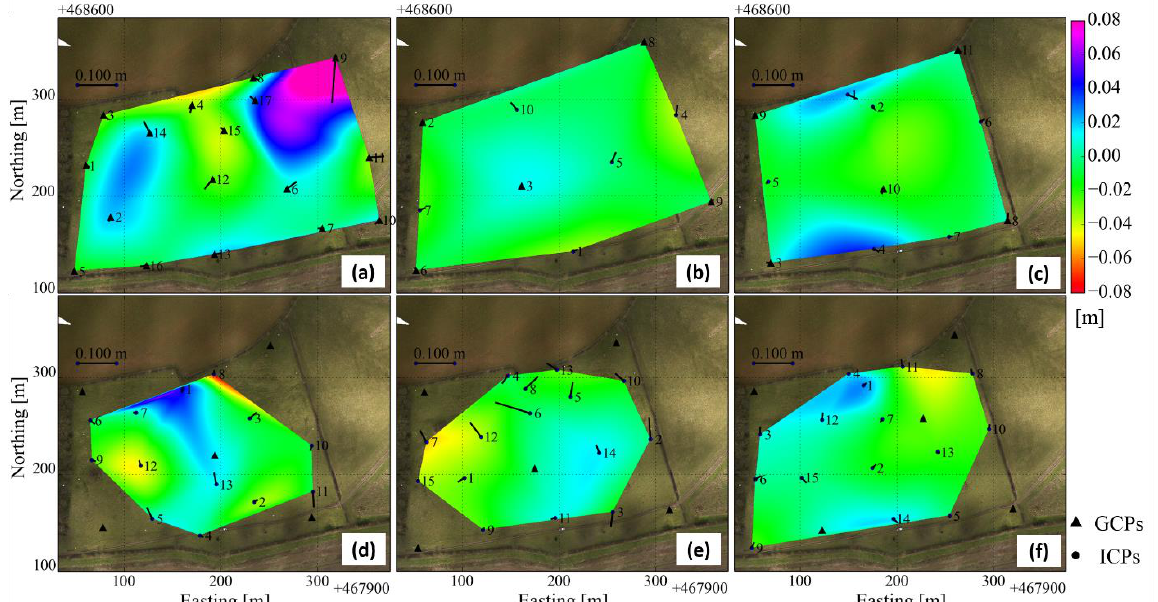
Figure 5. Planimetric and vertical RMSE errors at ICPs in (a) May 2014, (b) December 2014, (c) March 2015, (d) June 2015, (e) September 2015 and (f) February 2016 campaigns. For (a), (b) and (c) the errors are calculated for both GCPs and ICPs due to a relatively limited number of ICPs (see Table 1).